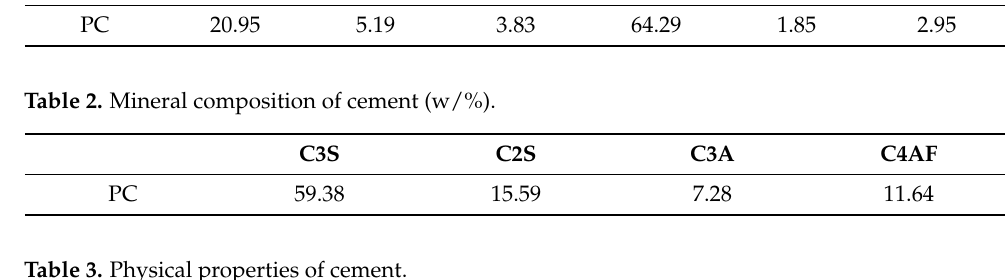
Table 3. Physical properties of cement.